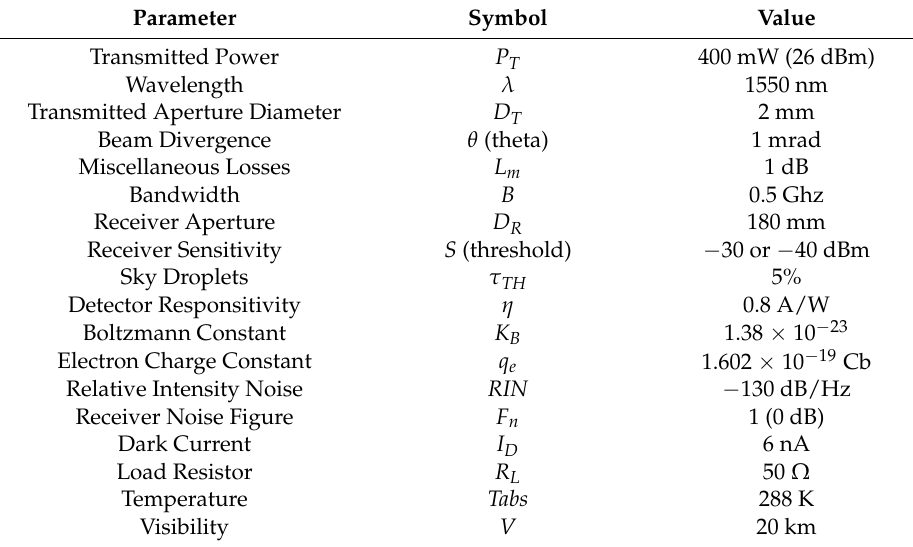
Table 1. The common parameter values of an FSO communication